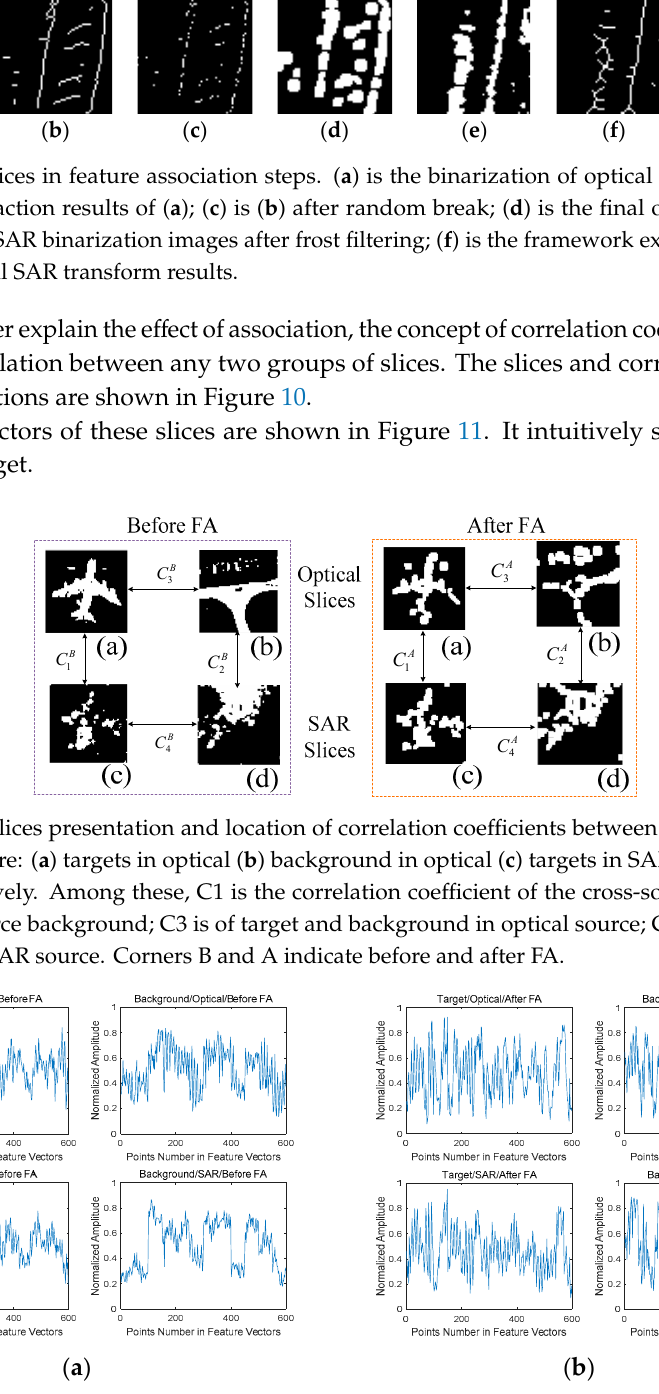
Figure 11. The feature vectors of target and background. ( a ) Before FA. ( b ) After FA.